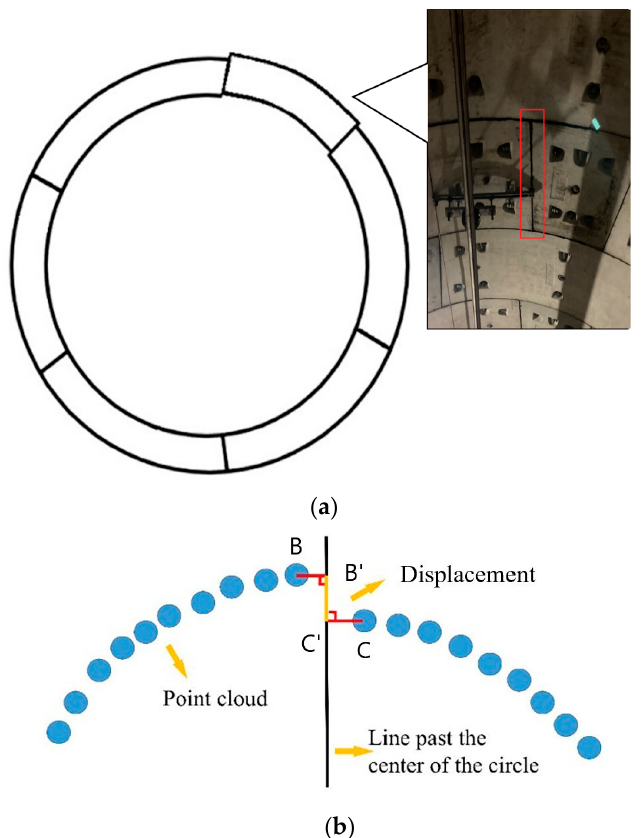
Figure 9. ( a ) Schematic radial displacement diagram and site photo of radial dislocation. ( b ) Local symmetric foot drop method.